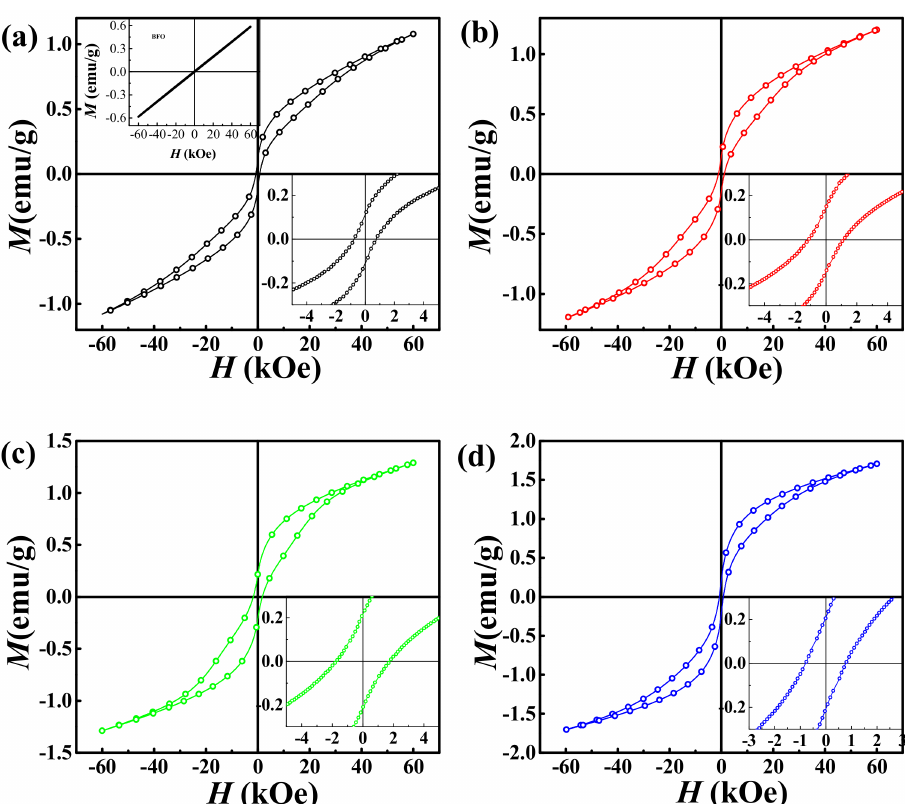
Figure 4. Room temperature M-H curves for La x Bi 1 − x Fe 0.95 Co 0.05 O 3 : ( a ) x = 0.05; ( b ) x = 0.10; ( c ) x = 0.15; ( d ) x = 0.20. The inset on the lower right is the magnified view. The inset on the high left in Figure 3a is the M - H curve for the parent BiFeO 3